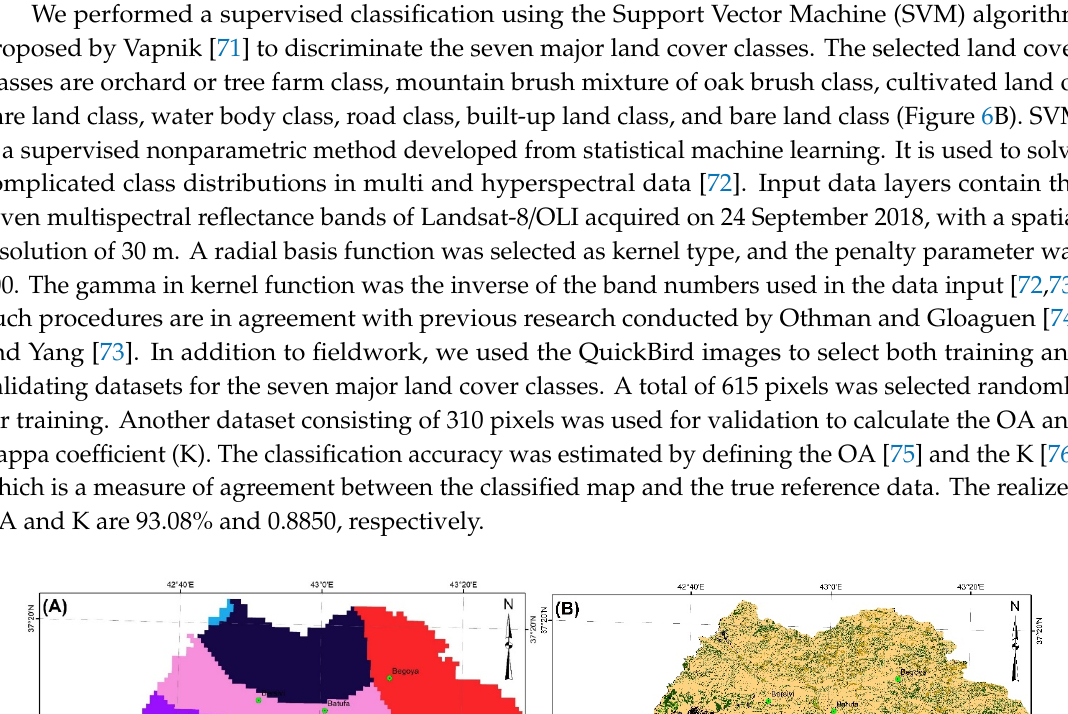
Figure 7. Maps of: ( A ) elevation, and ( B ) slope gradient of the study area. In addition, DEM was also used to extract slope attribute. The steepness of slopes is a major factor in dam site selection. Lands with gentle slopes are more suitable for dam sites location, and vice versa [79].